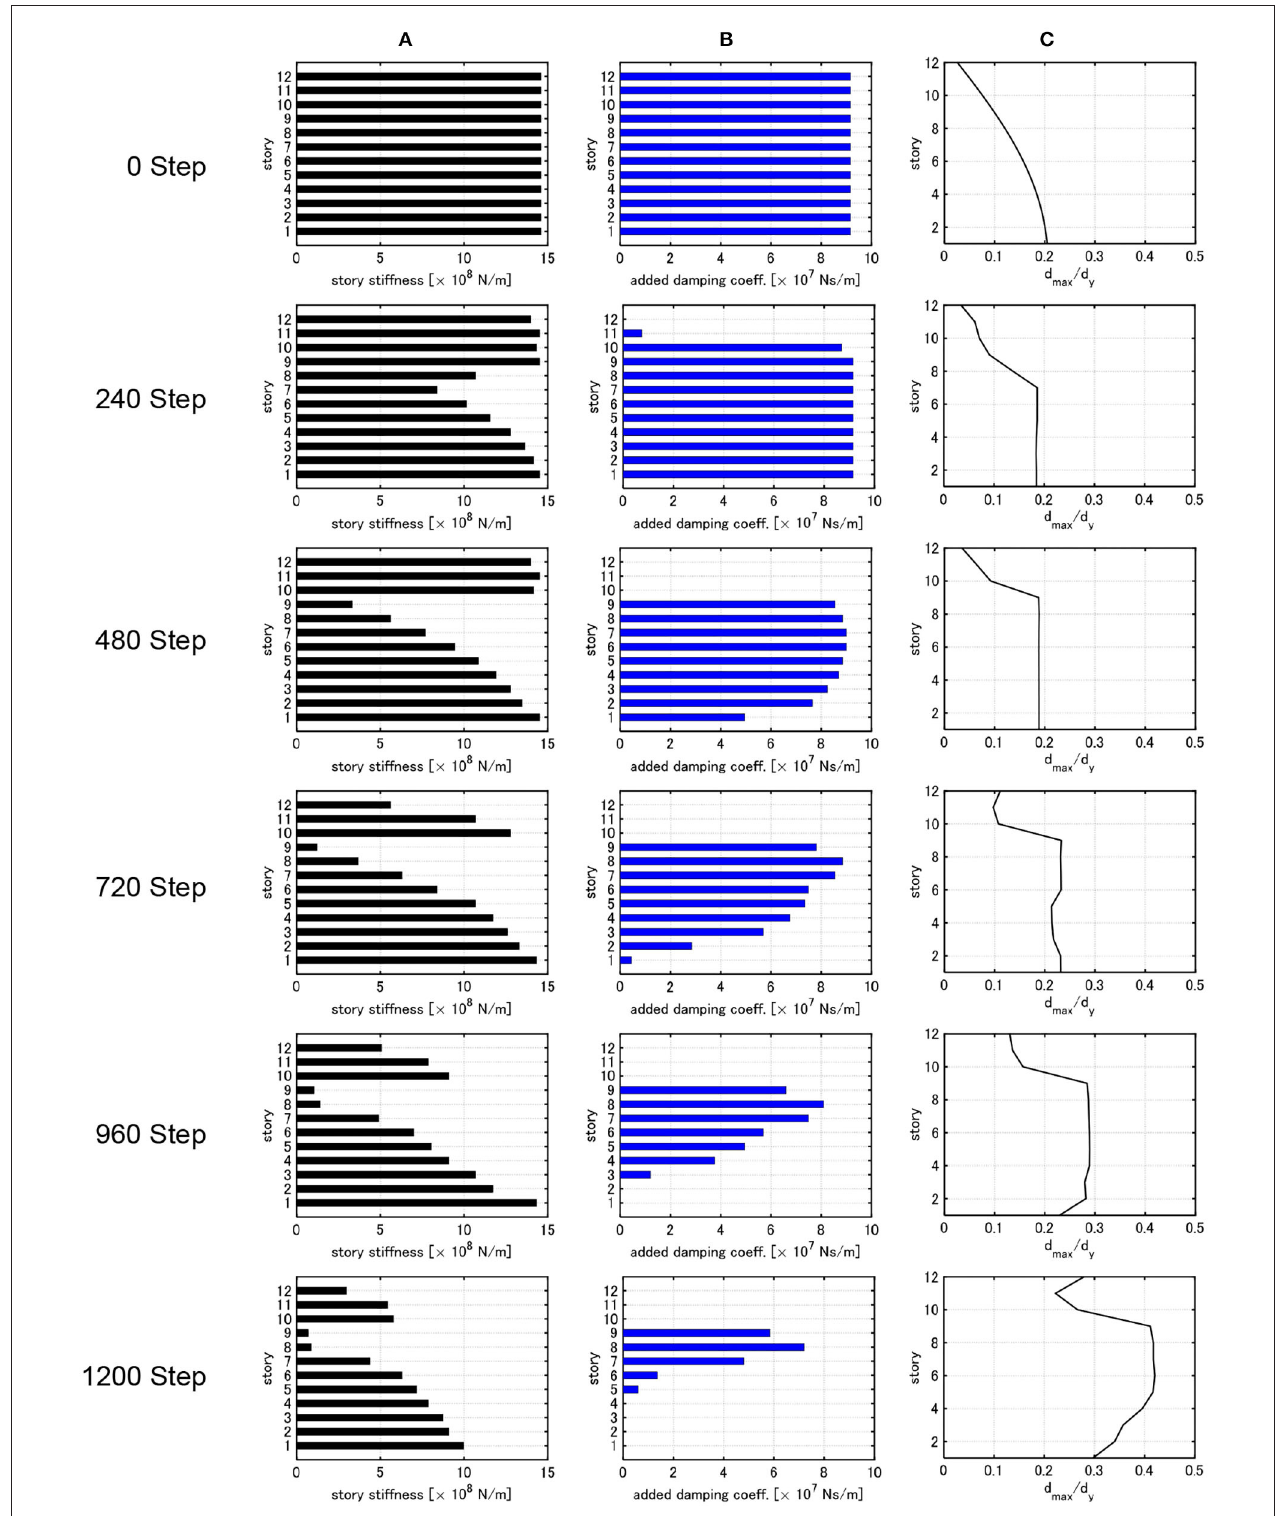
FIGURE 5 | Change of distribution of story stiffness, distribution of added damping coefficient and distribution of d max, i / d y throughout process of optimization ( n k = n c = 60, n kc = 10). (A) Distribution of story stiffness. (B) Distribution of damper damping coefficient. (C) Distribution of d max, i / d y .